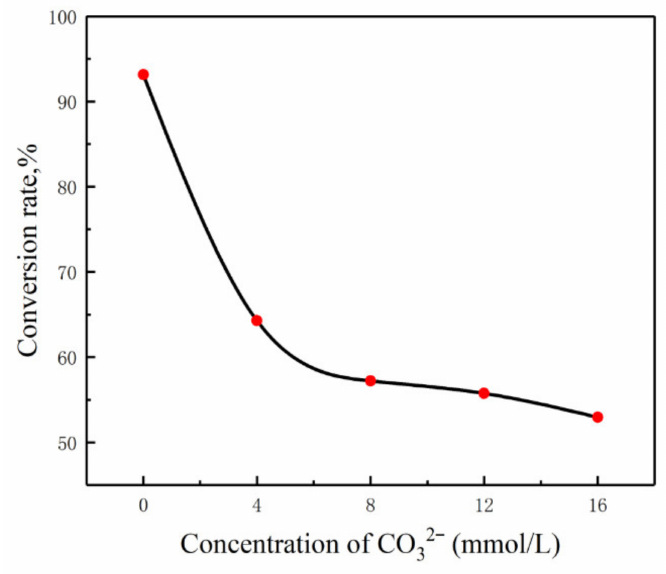
Figure 9. Effect of concentration of CO 3 2 − on the digestion of ammonium